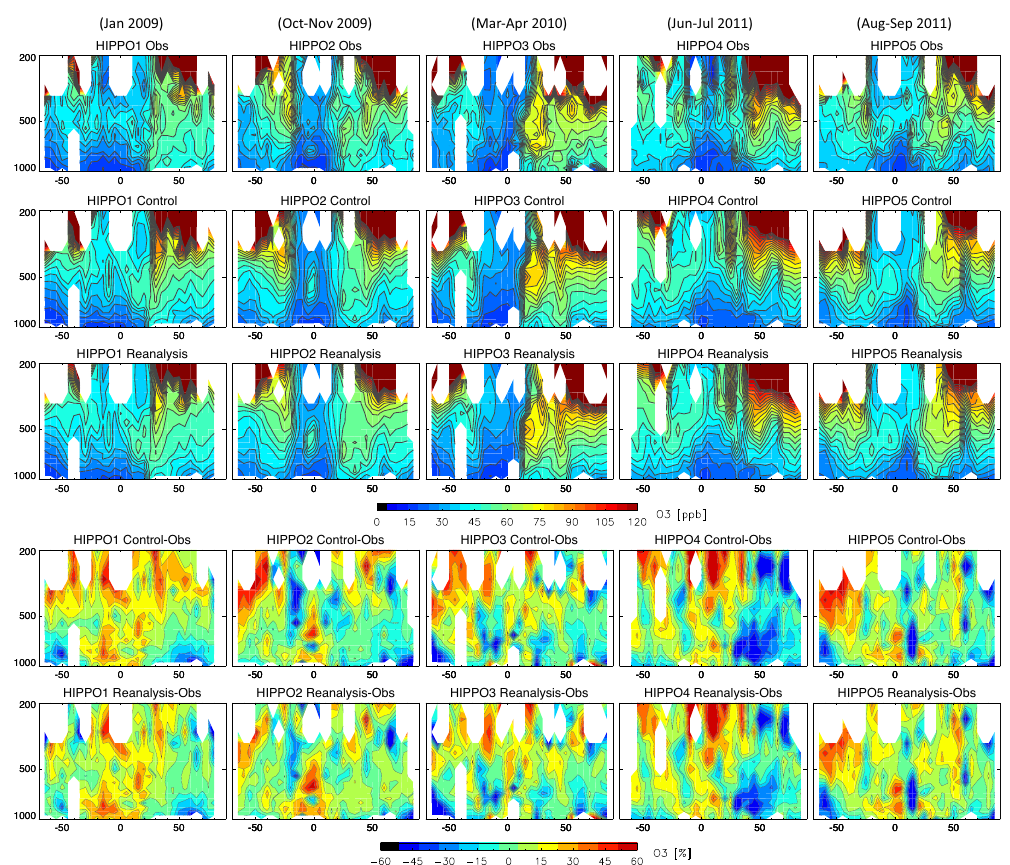
Figure 9. Latitude–pressure cross section of mean O 3 concentration (in ppb) obtained from HIPPO aircraft measurements (first row), control run (second row), and reanalysis (third row). The relative difference (in %) between the control run and the observation (fourth row) and between the reanalysis and the observation (fifth row) is also shown. Results are shown for all HIPPO campaigns (from left to right: HIPPO I, 8–30 January 2009; HIPPO II, 31 October to 22 November 2009; HIPPO III, 24 March to 16 April 2010; HIPPO IV, 14 June to 11 July